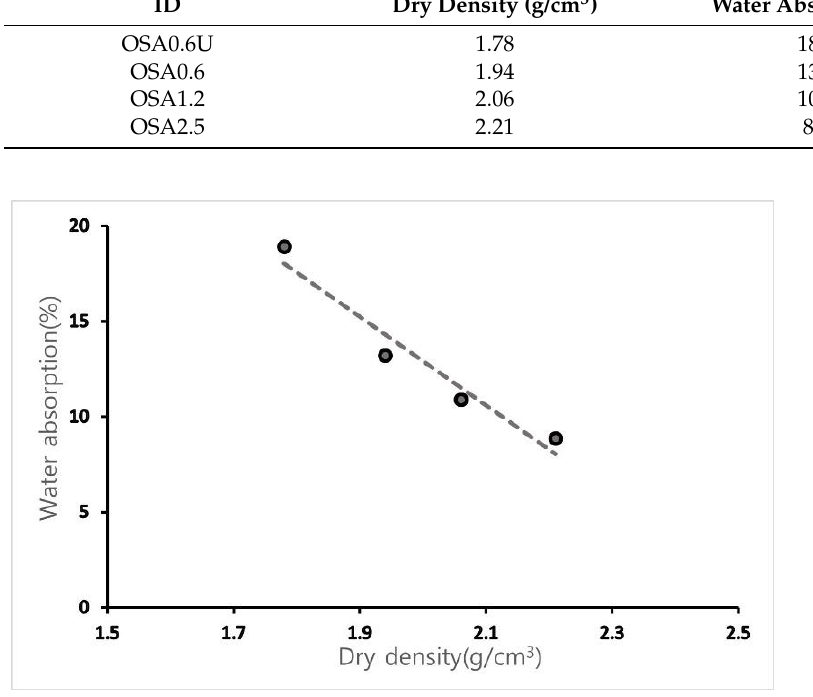
Figure 5. Dry density – water absorption of the oyster shells.